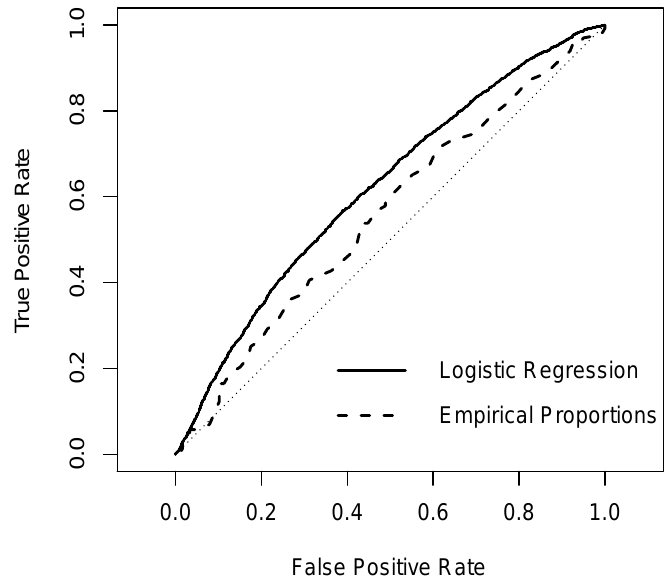
Figure 1. Relative operator characteristic curves for system length forecasts. The diagonal line, False Positive Rate = True Positive Rate, illustrates the performance of a random forecast, e.g., a random forecast of 70% would be expected to correctly predict 70% of all positive outcomes, and falsely predict that 70% of negative outcomes would be